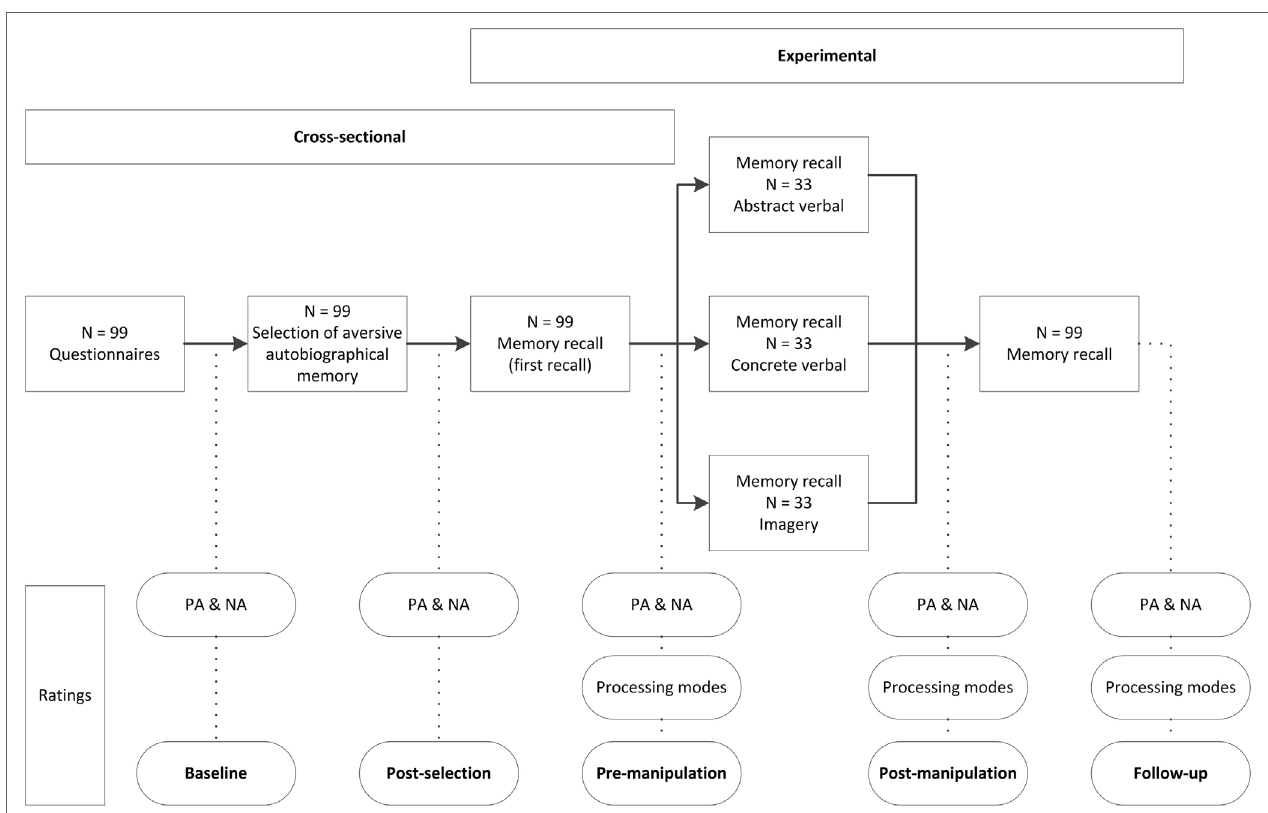
FigUre 1 | Overview of study procedure of the observational and experimental part of the study